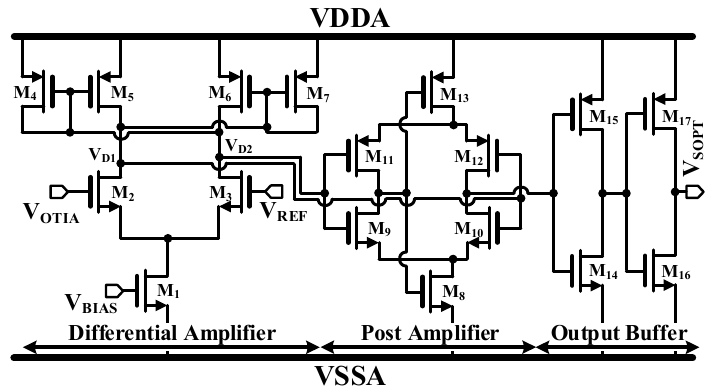
Figure 7. Simplified schematic of a timing comparator.